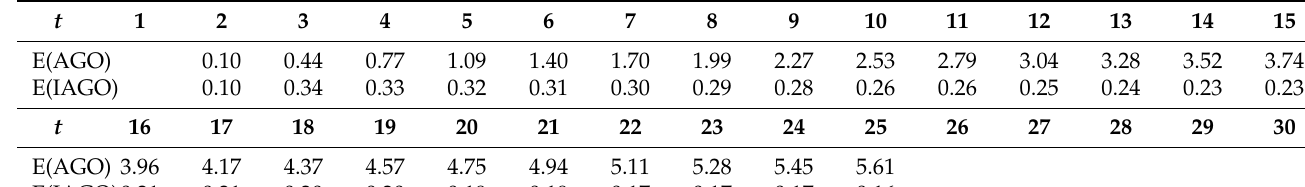
Figure 10. Four simulations of AGO series. After one thousand simulations of Equation (53), the following expected AGO and corresponding IAGO outcomes are presented in Table 13. Figure 11 presents the probabil- ity distribution function of the AGO series for t = 10. Table 13. Expected AGO and corresponding IAGO outcomes.